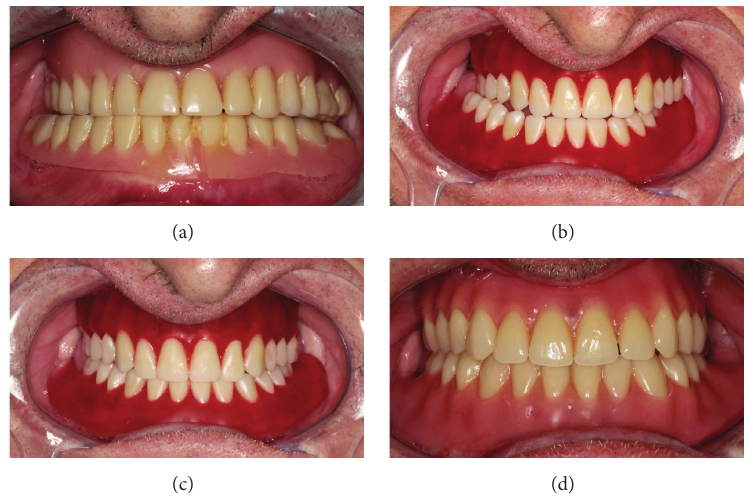
Figure 1: (a) Old complete dentures. (b) Repetitive movement with Biotone artificial teeth. (c) Trial complete dentures with Biotone artificial teeth. (d) Complete dentures with Premium artificial teeth.